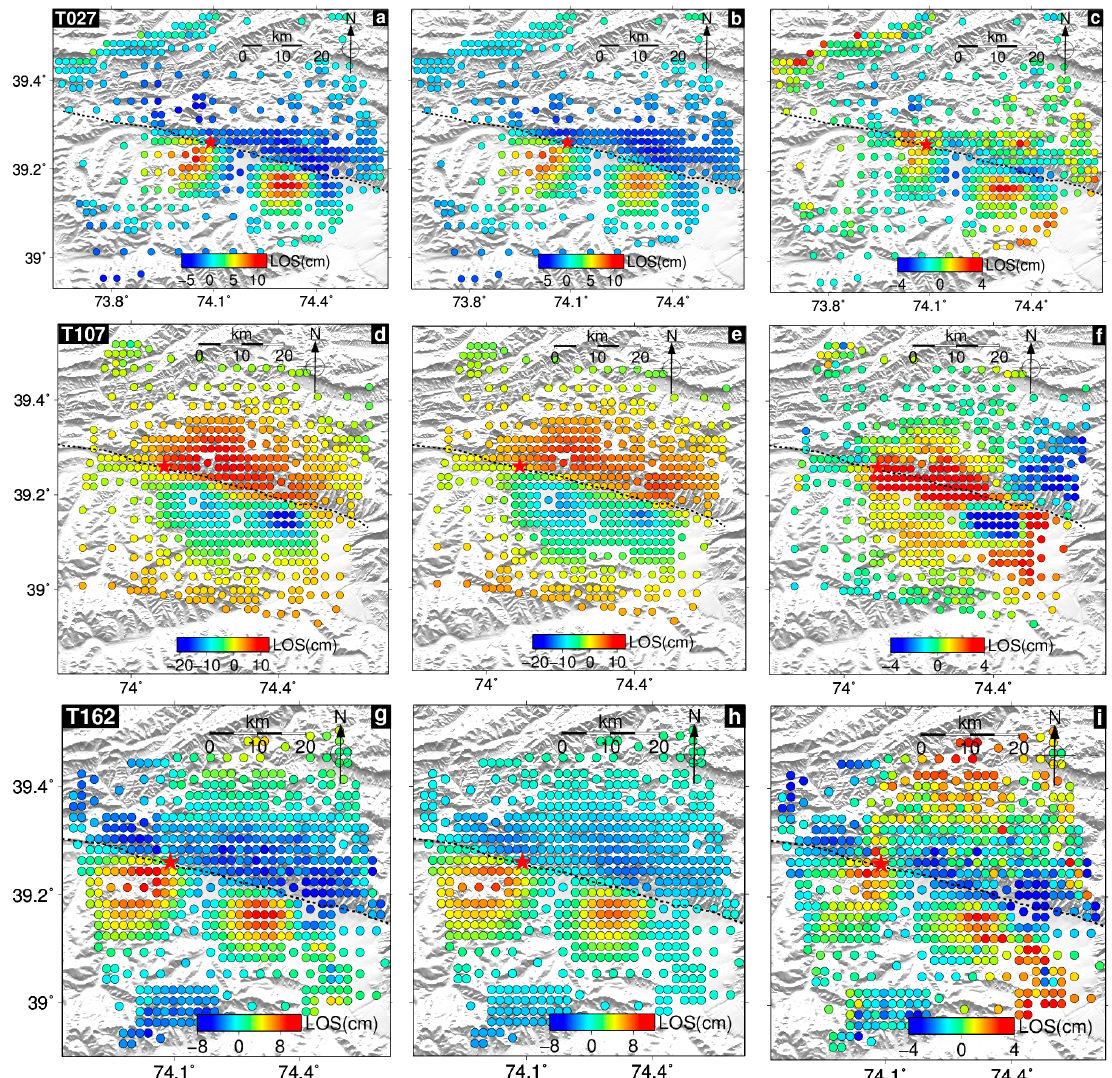
Figure 4. Observed InSAR coseismic deformations, predictions by our slip model, and the residuals between them. ( a , d , g ) are the LOS deformation field at downsampled data points from Sentinel-1A ascending track T027A, Sentinel-1B descending track T107D and ALOS-2 ascending track T162A, respectively; ( b , e , h ) are the corresponding model predictions, with ( c , f , i ) being the respective residuals from fitting. For clarity, the residuals are shown with a − 4–4 cm color palette.